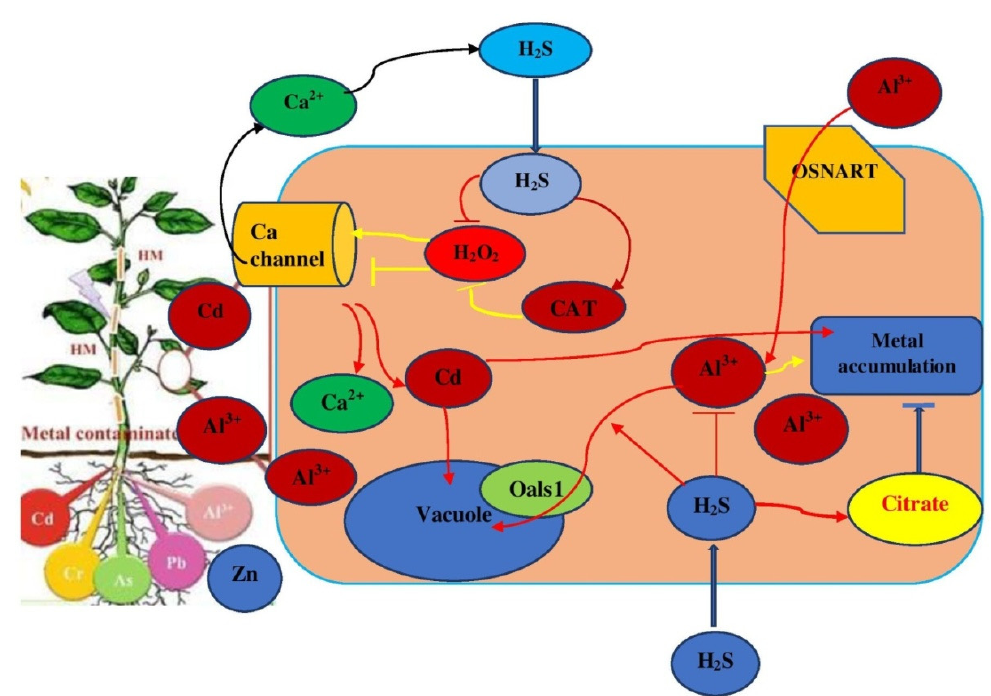
Figure 4. Schematic representation of H 2 S-mediated responsive pathway in plants towards heavy metal stresses. Various heavy metals such as Cd, Pb, Zn, Al, As, Cu, Cr, etc., enter the plants and after entering the plant cell Ca-channels induce H 2 S responses in plants that further induce the antioxidative enzyme activities. The free radicals produced are also scavenged through different metabolites such as citrate activated by H 2 S and tend to chelate metal ion or stabilize them to prevent their accumulation. In addition, H 2 S promotes metal ion sequestration in vacuoles.